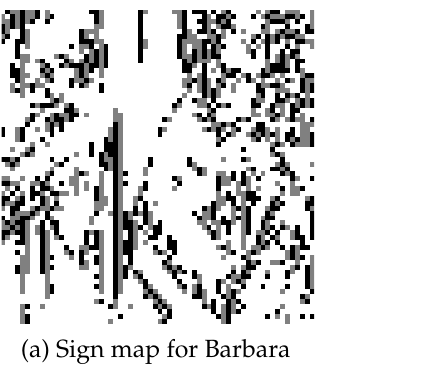
Figure 1. Sign patterns in the HL subband for Barbara ( a ) and Lena ( b ) images. Black, grey and white dots represent negative, positive and non-significant coefficients, respectively